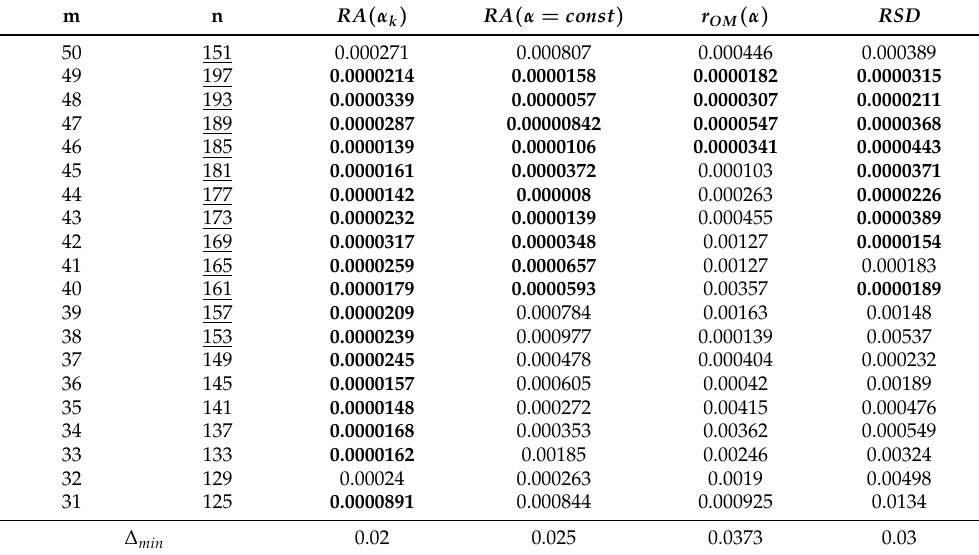
Table 9. Results of function f 6 ( x ) approximation by a sigmoidal ANN with a regularizer R 1 ( w )